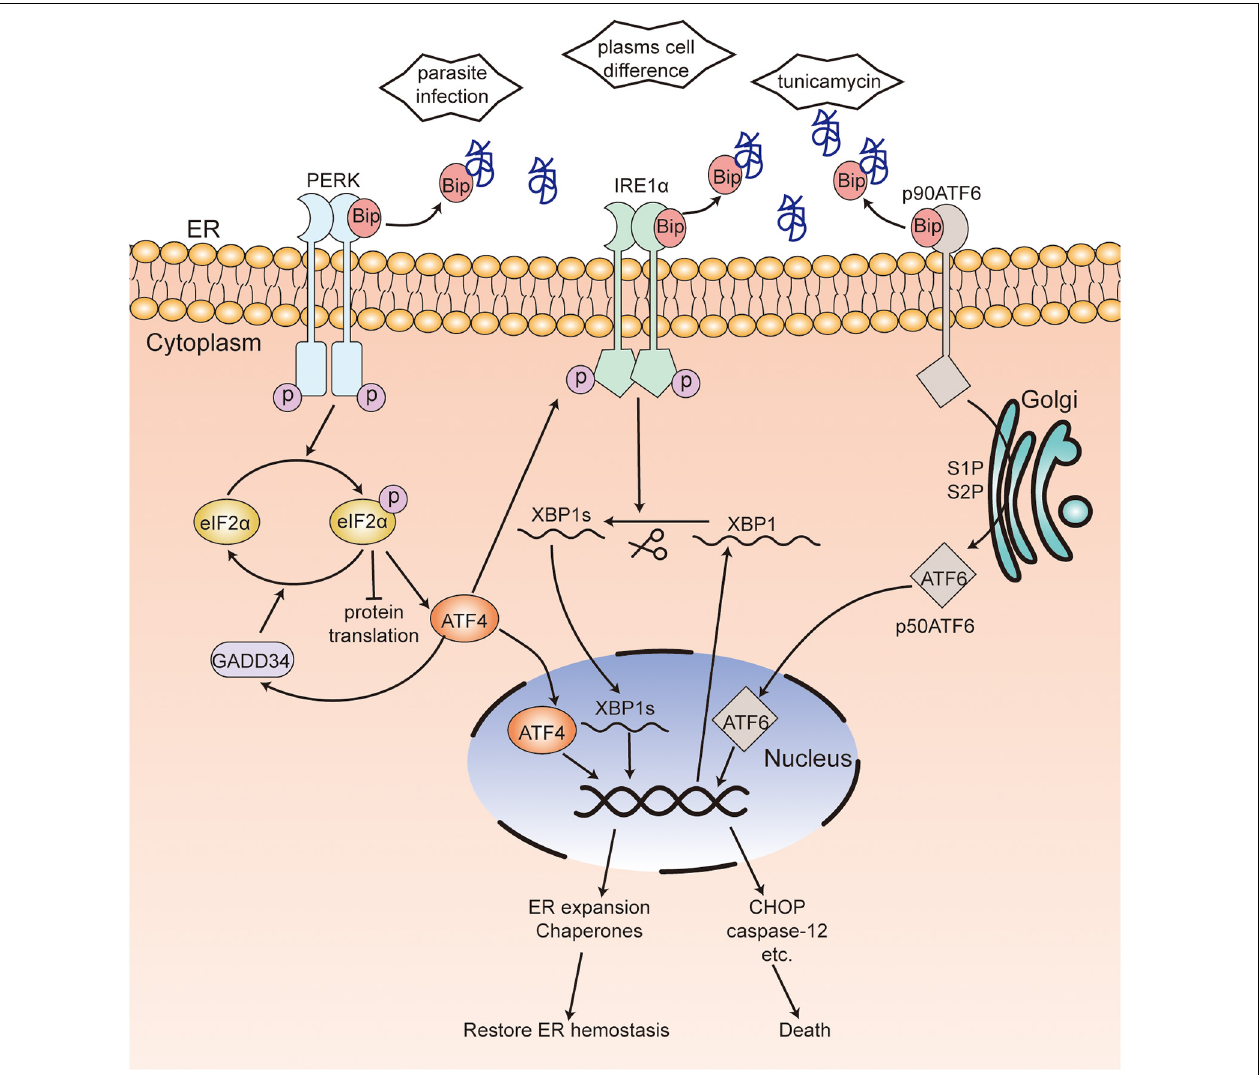
FIGURE 1 | Unfolded protein response in mammalian cells. In unstressed cells, Bip binds to three transmembrane proteins PERK, IRE1 α and ATF6. When ER stress occurs, Bip dissociates from these transmembrane proteins and binds to unfolded or misfolded proteins. Activated PERK, induced by oligomerization following dissociation from Bip, phosphorylates eIF2 α , which reduces protein translation while upregulating the expression of ATF4. eIF2 α phosphorylation can be dephosphorylated by GADD34. After dissociation from Bip, IRE1 α is activated by forming IRE1 α homodimers and incises XBP1 mRNA into XBP1s. Bip releases from ATF6, which leads to the translocation to Golgi and activation of ATF6. ATF4, XBP1s, and activated ATF6 enter the nucleus and activate the transcription of ER chaperones or various death effectors, which results in the restoration of ER hemostasis or cell death. [ ], unfolded or misfolded proteins; PERK, protein kinase RNA-like ER kinase; IRE1, inositol-requiring kinase/endoribonuclease 1; eIF2 α , α -subunit of eukaryotic translational initiation factor 2; ATF6, activating transcription factor 6; ATF4, activating transcription factor 4; XBP1, X box-binding protein 1; CHOP, C/EBP-homologous protein; Bip, immunoglobulin heavy chain binding protein; GADD34, DNA damage-inducible protein-34.